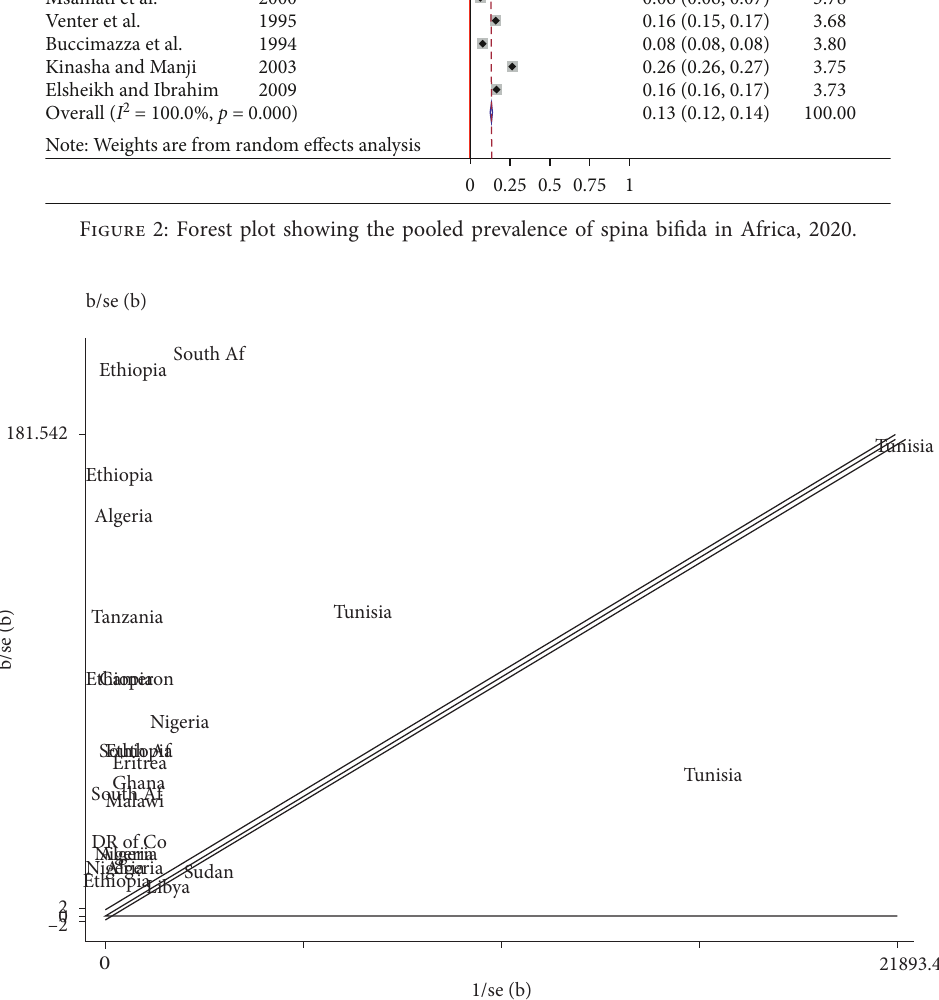
Figure 3: Galbraith plot showing the variability of the pooled prevalence of spina bifida in Africa,